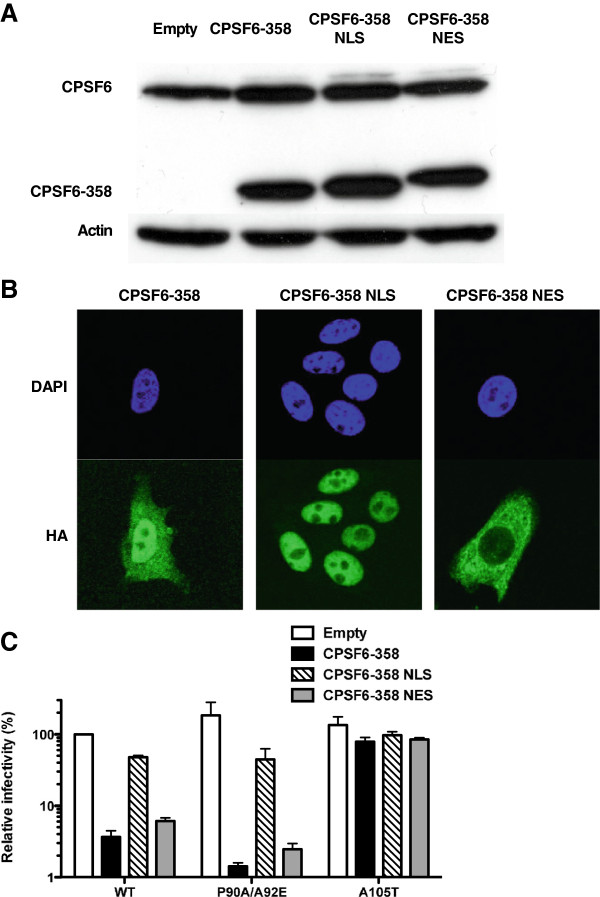
CPSF6-358 inhibits HIV-1 replication when localized to the cytoplasm. (A) CPSF6 protein in TZM-bl cells transduced with empty, CPSF6-358, CPSF6-358 NLS and CPSF6-358 NES vectors. Cell lysates were probed in western blots with anti-CPSF6 antibody (upper panel) and anti-β-actin antibody (lower panel). The upper panel shows the endogenous CPSF6 and the truncated form. (B) Indirect immunofluorescence showing localization of the different forms of CPSF6-358. The TZM-bl cells, transduced as in (A), were stained with an anti-HA antibody (green) for the detection of the CPSF6-358 proteins. DAPI was used to mark the nuclear compartment (blue). (C) TZM-bl stably expressing the different forms of CPSF6-358 were challenged with WT or CA mutant HIV-1NL4-3GFP reporter viruses. After 72 hrs, GFP reporter expression was assessed by flow cytometry. Data represent one of at least three independent experiments. Error bars represent ± SEM (n = 3).